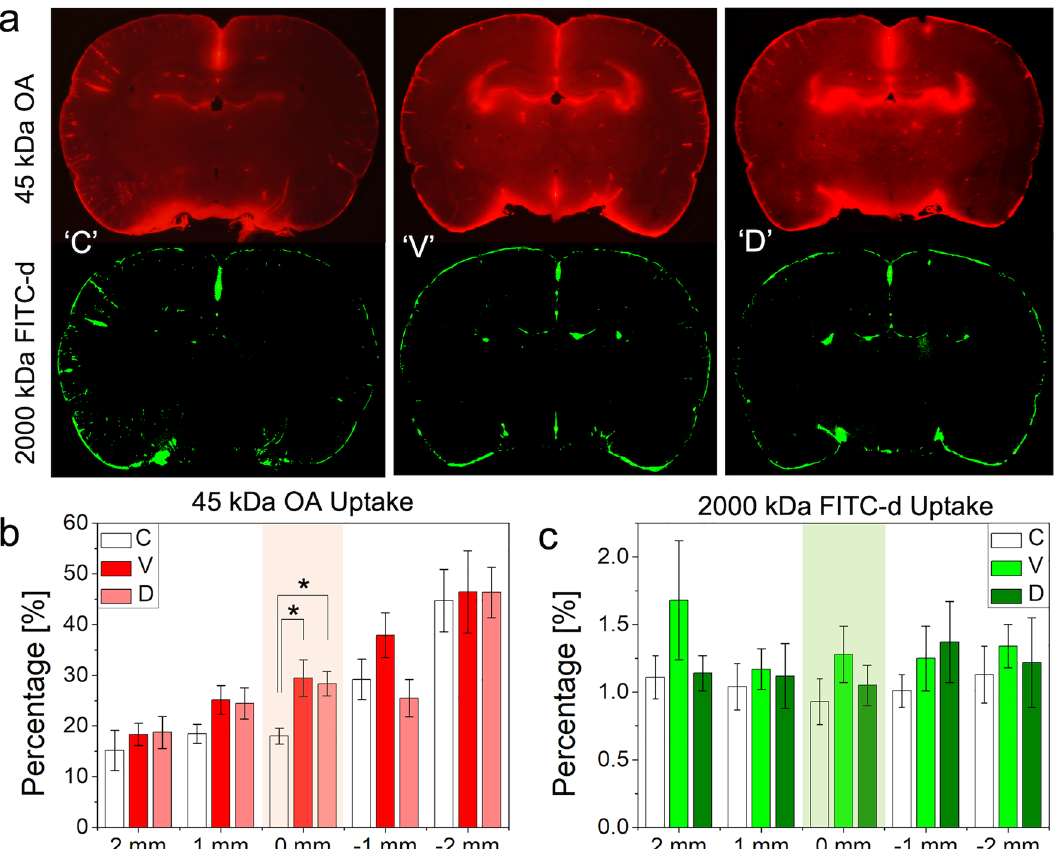
Figure 4. Image analysis of CSF tracer distribution across the experimental condition. ( a ) An exemplar image of OA (in red) and FITC-d (in green) at the coronal planes of sonication across no FUS (‘C’) and FUS conditions (‘V’ and ‘D’). ( b ) % uptake of OA and ( c ) FITC-d ( n = 6 in each group) across the rostral ( +) and caudal (− ) planes surrounding the sonication (shown in mm;—rostral, + caudal). Colored sections indicate the location of the acoustic focus. *: P < 0.05; error bars: standard